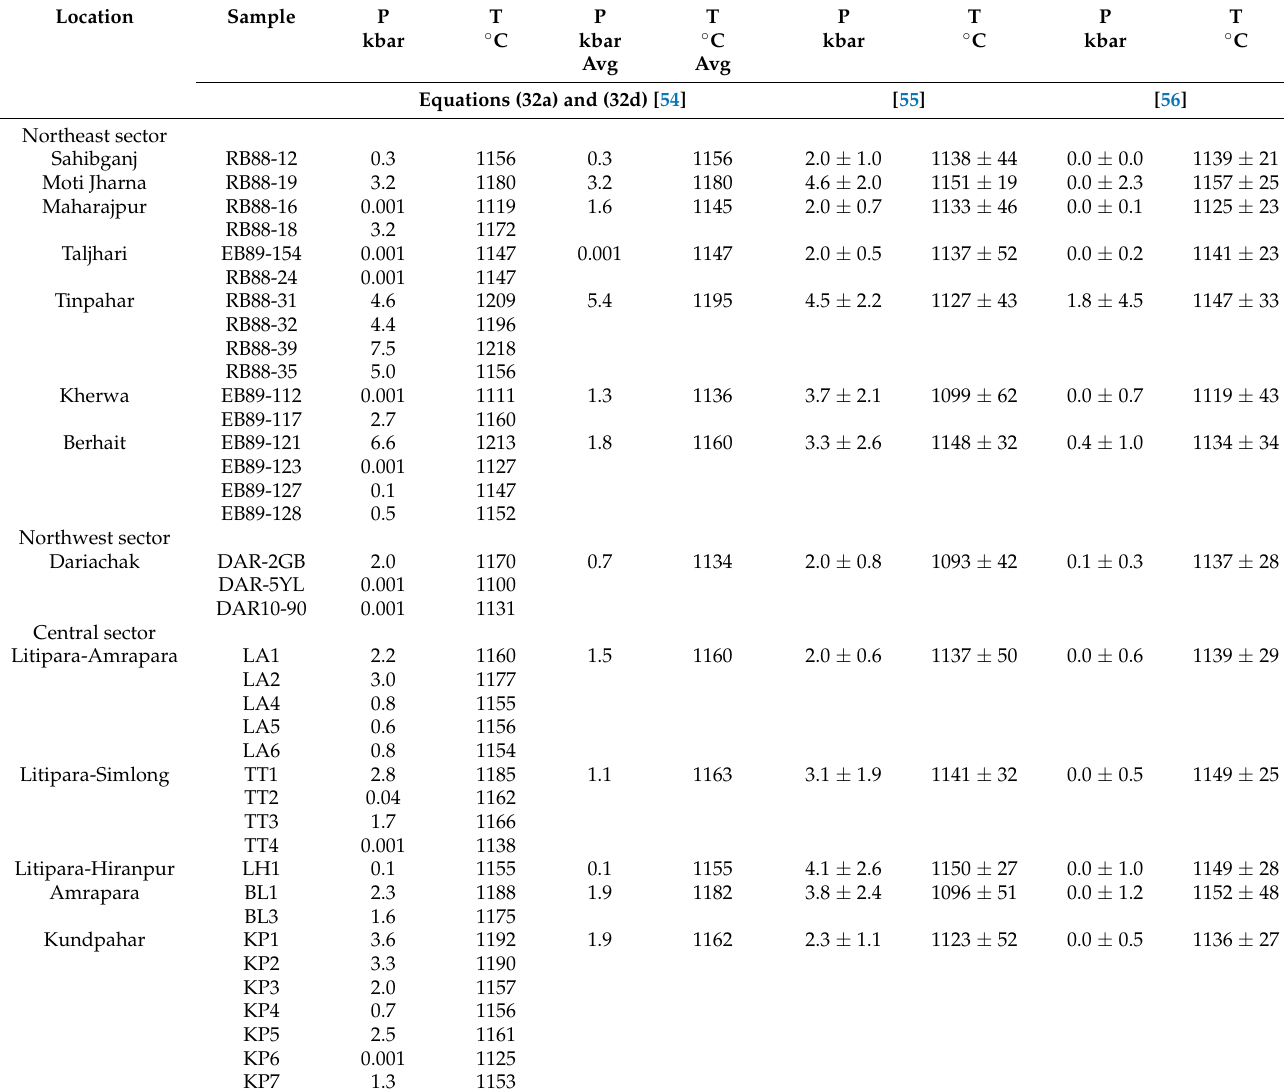
Table 3. Clinopyroxene thermobarometry of the Rajmahal basalts.